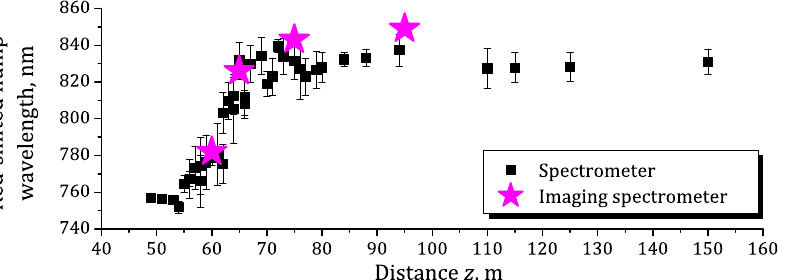
Figure 7. The dependence of the brightest red-shifted hump wavelength obtained by the spectrome- ter (black squares) and the imaging spectrometer (magenta stars) on the propagation distance. Error bars represent the standard deviation of the longest red shift over 10–20